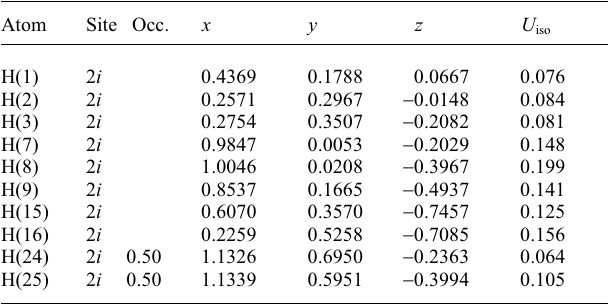
Table 2. Atomic coordinates and displacement parameters (in Å 2 )